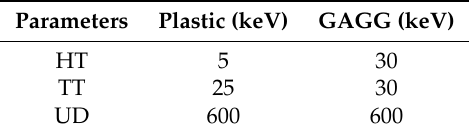
Table 2. Parameters applied for plastic scintillator and GAGG